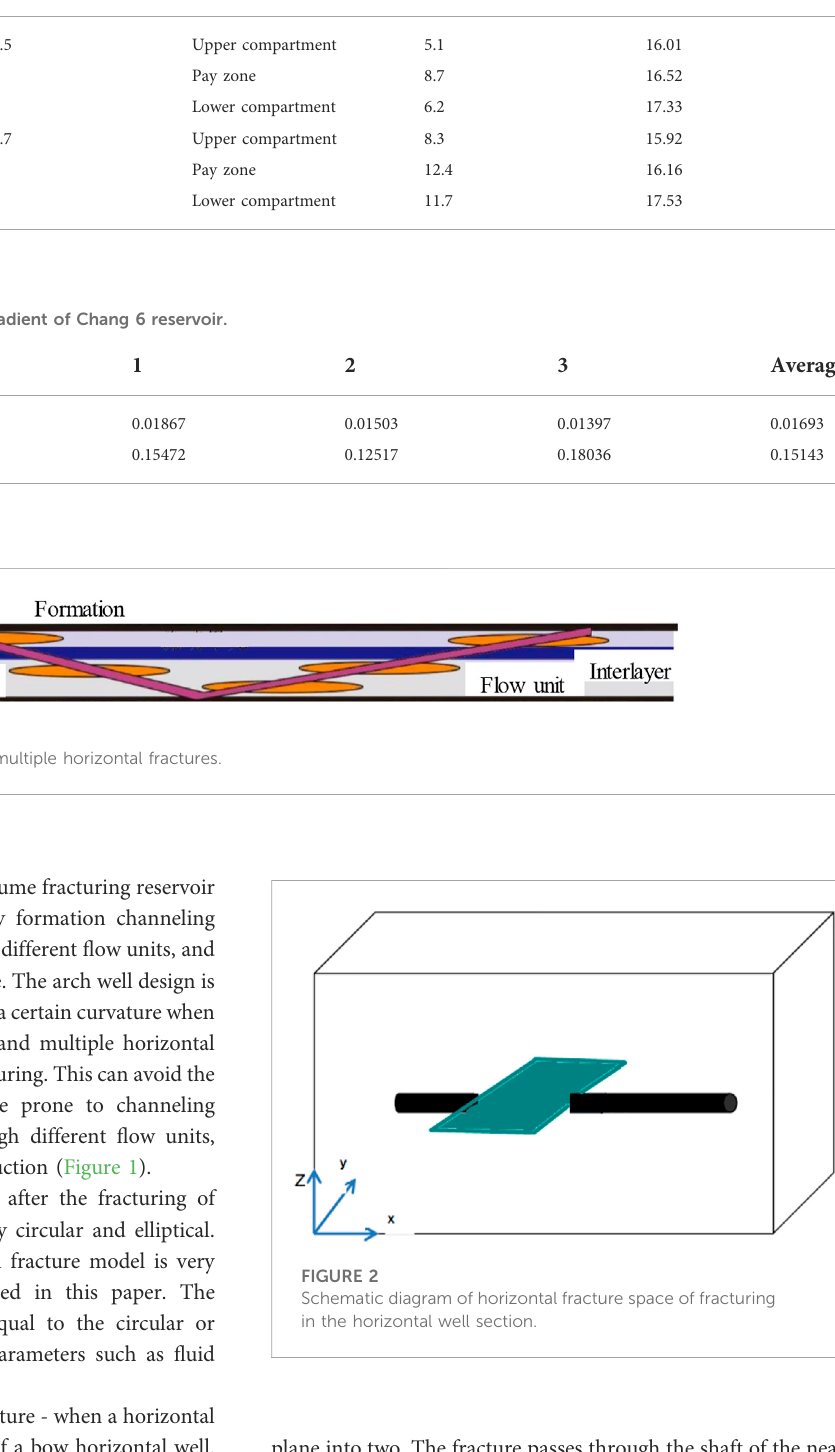
TABLE 2 Basic parameters of horizontal stress of production interlayer. Horizon Well no.